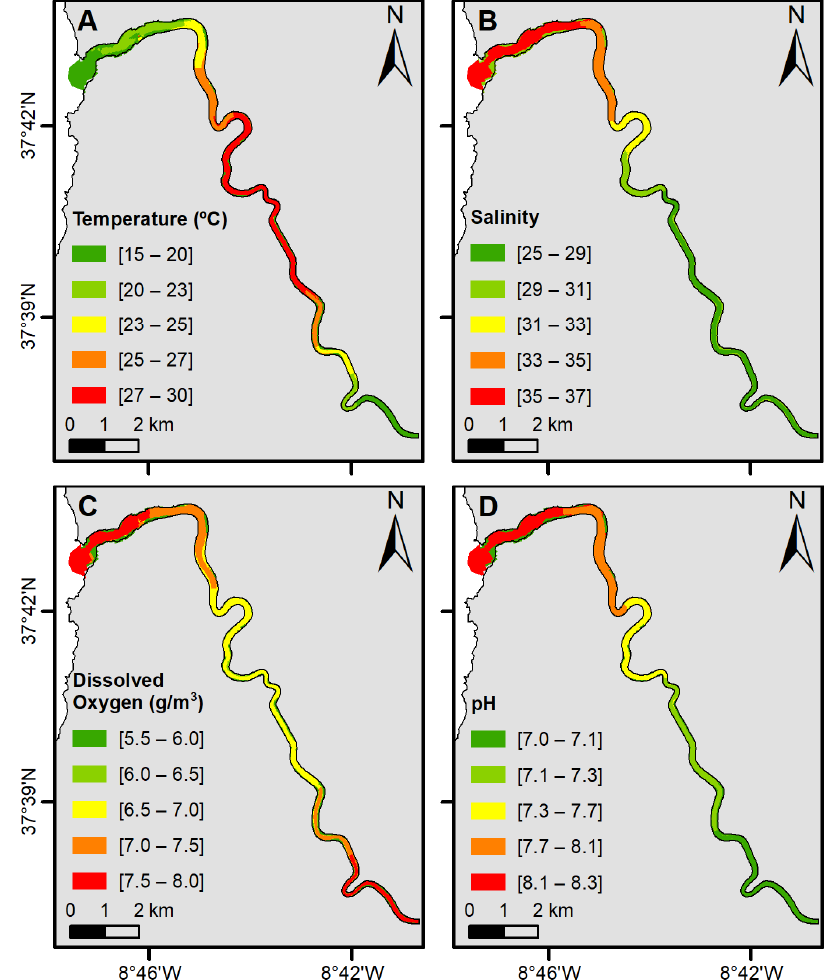
Figure 9. Annual mean water temperature (°C) ( A ), salinity ( B ), DO (g/m 3 ) ( C ), and pH ( D ) for Mira Estuary.